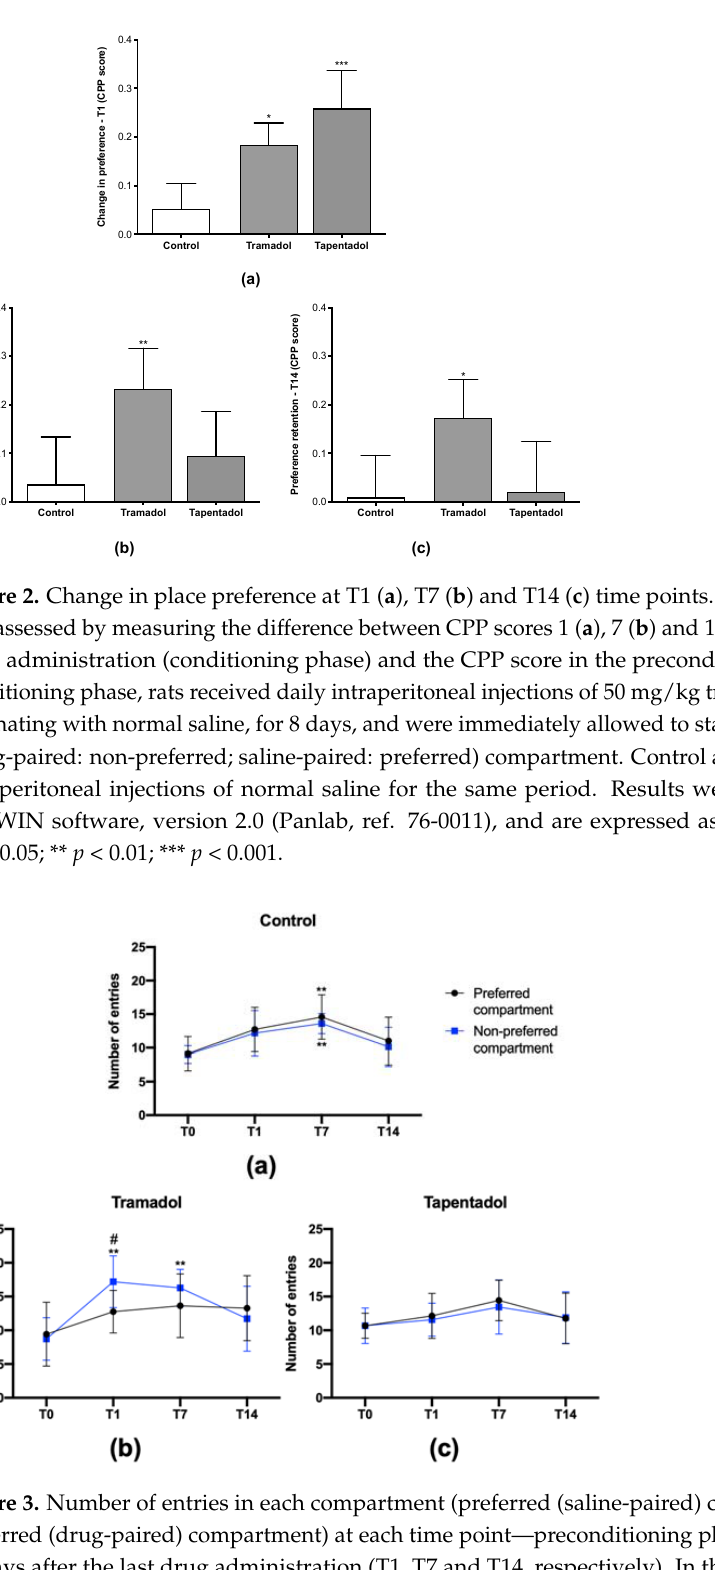
Figure 2. Change in place preference at T1 ( a ), T7 ( b ) and T14 ( c ) time points. Change in preference was assessed by measuring the difference between CPP scores 1 ( a ), 7 ( b ) and 14 ( c ) days after the last drug administration (conditioning phase) and the CPP score in the preconditioning phase. In the conditioning phase, rats received daily intraperitoneal injections of 50 mg/kg tramadol or tapen ‐ tadol, alternating with normal saline, for 8 days, and were immediately allowed to stay in a pre ‐ determined (drug ‐ paired: non ‐ preferred; saline ‐ paired: preferred) compartment. Control animals received daily intraperitoneal injections of normal saline for the same period. Results were recorded with the PPCWIN software, version 2.0 (Panlab, ref. 76 ‐ 0011), and are expressed as means ± SD ( n =